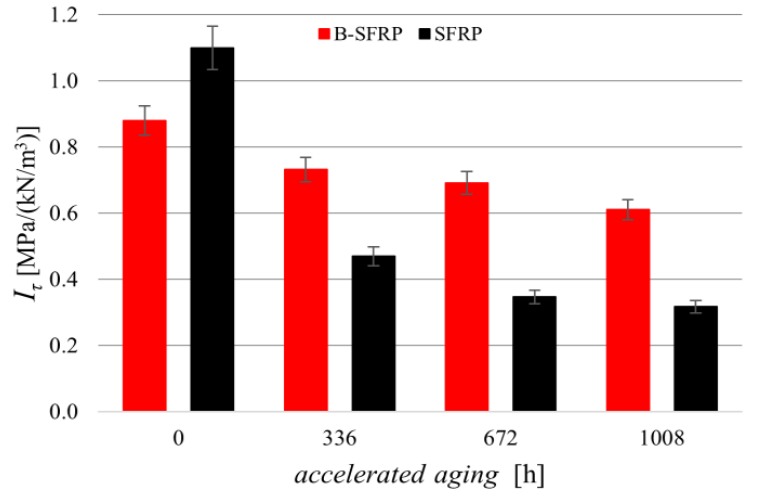
Figure 17. Delamination strength of the biocomposites examined, before and after accelerated aging.